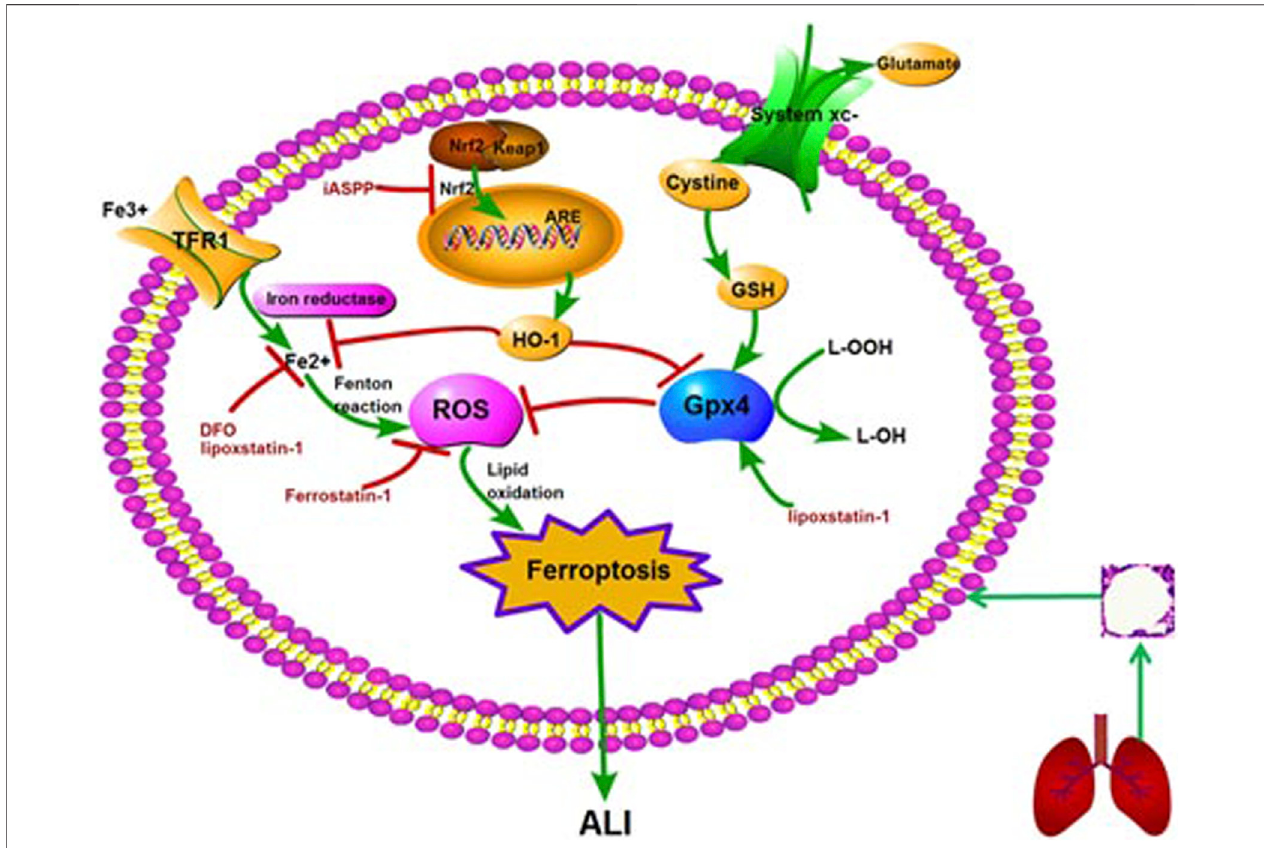
FIGURE 1 | The molecular mechanism and regulation of ferroptosis in ALI. Note: ALI: acute lung injury; GSH: glutathione peroxidase 4; ROS: reactive oxygen species; Nrf2: nuclear factor erythroid 2-related factor 2; HO-1: heme oxygenase-1; ARE: antioxidant response element; TFR1: transferrin receptor 1; DFO: deferoxamine; iASSP: inhibitor of apoptosis-stimulating protein of